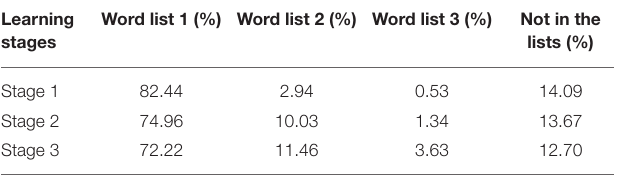
TABLE 1 | Percentage of word types per learning stage. Learning stages